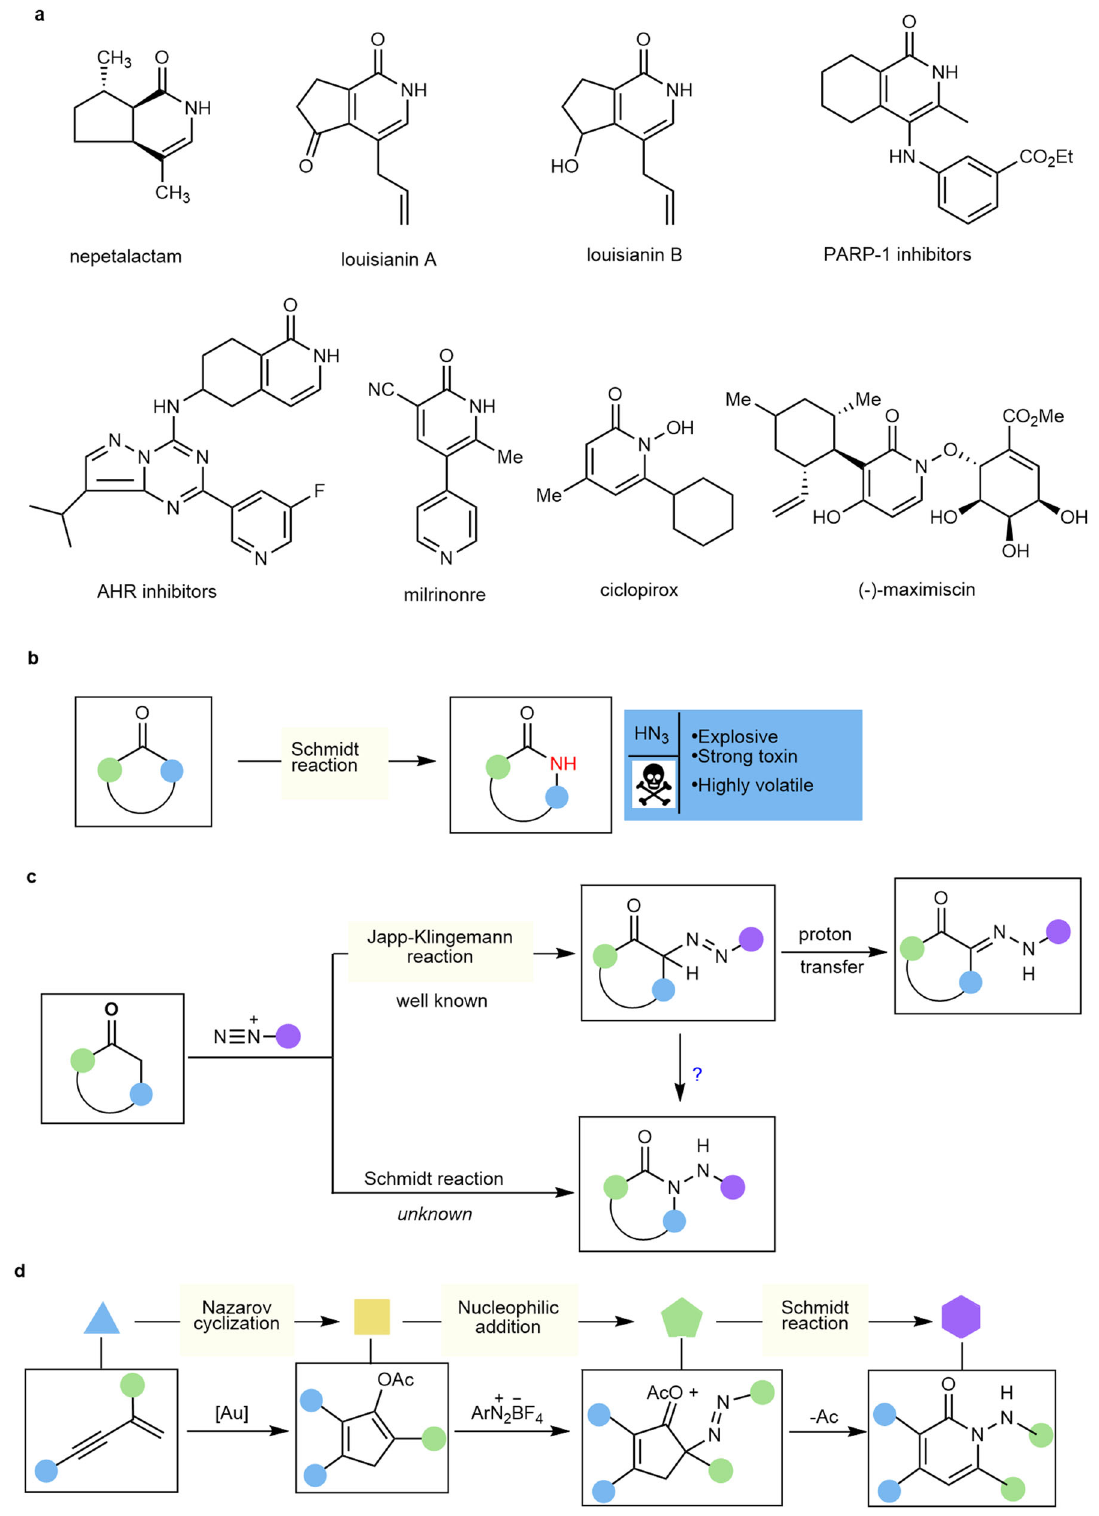
Fig. 1 | Azoarene activation for the Schmidt reaction. a Natural products and bioactive molecules containing 2-pyridinone structures. b Traditional Schmidt reaction withazides asthe limiting reagent. c Reactivity patterns of